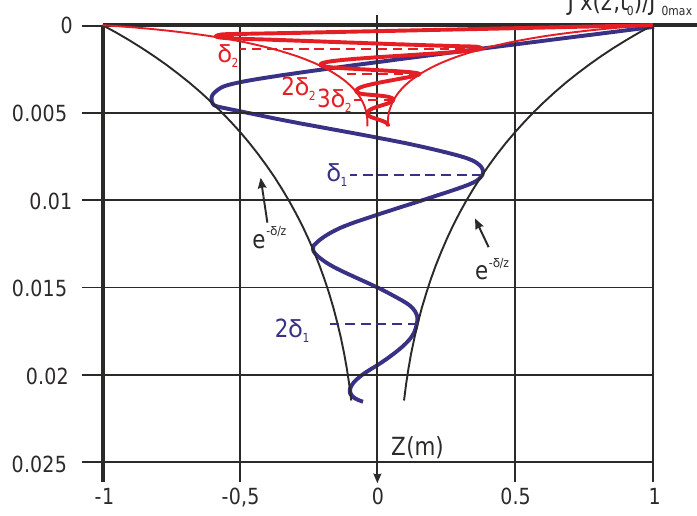
Figure 14. Electromagnetic field penetration inside pure aluminum at frequencies of 200 Hz and 10 KHz (adapted from